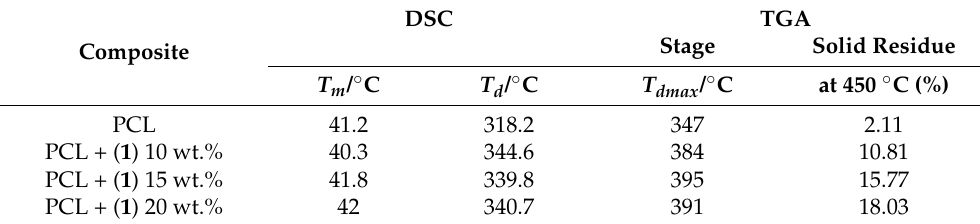
Table 3. Thermal parameters received from thermogravimetric analysis (TGA) and differential scanning calorimetry (DSC) of the composites ( T m = melting temperature, T d = decomposition onset temperature, T d/max = decomposition temperature, ∆ m = thermal transition weight